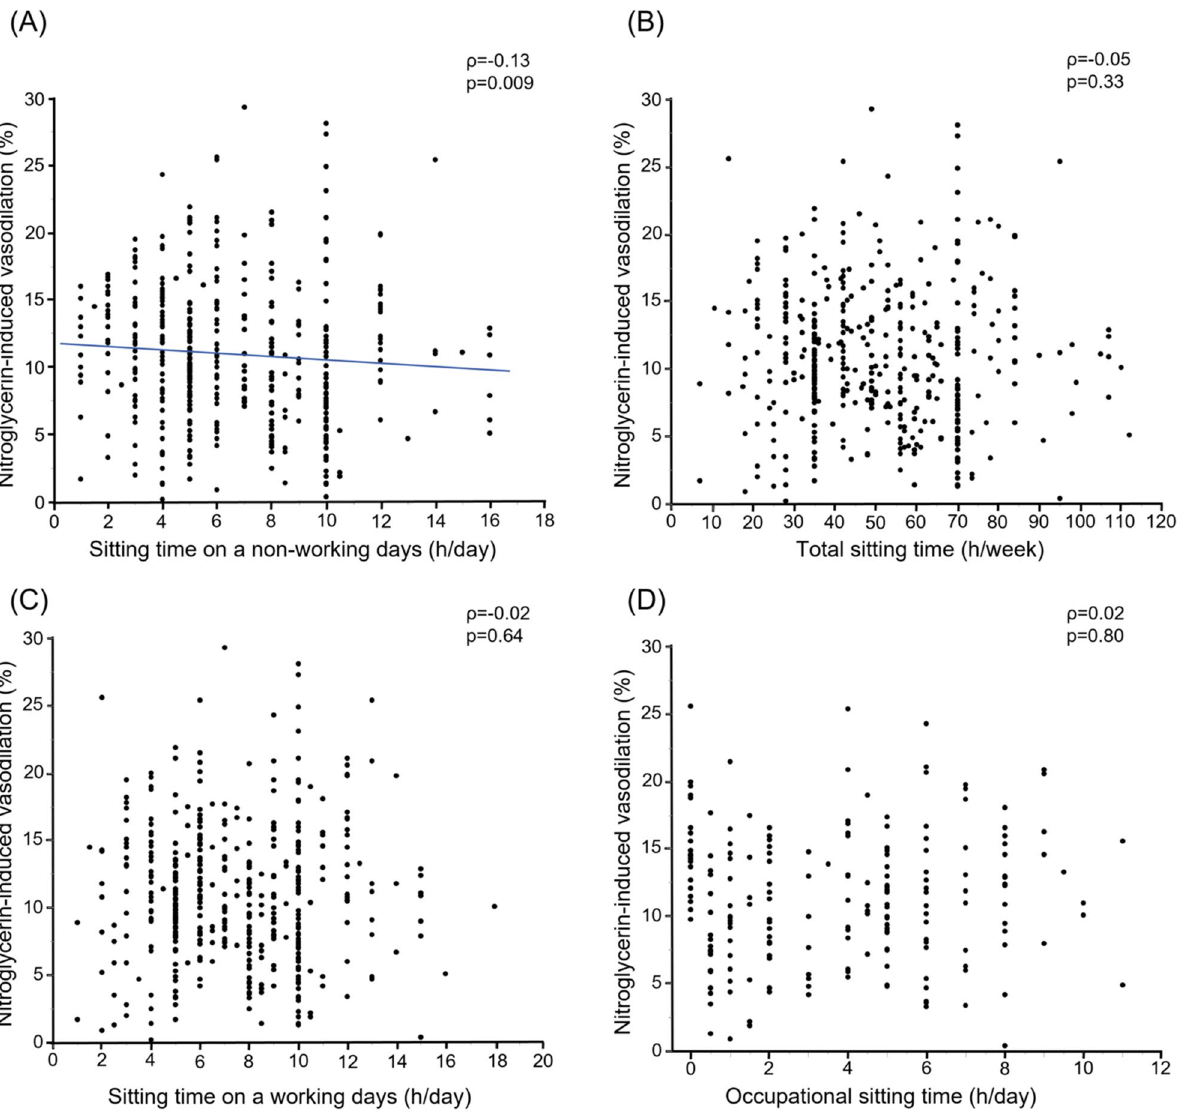
Figure 4. Scatter plots show the relationships of nitroglycerine-induced vasodilation with sitting time on a non- working day ( A ), total sitting time ( B ), sitting time on a working day ( C ), and occupational sitting time ( D ).